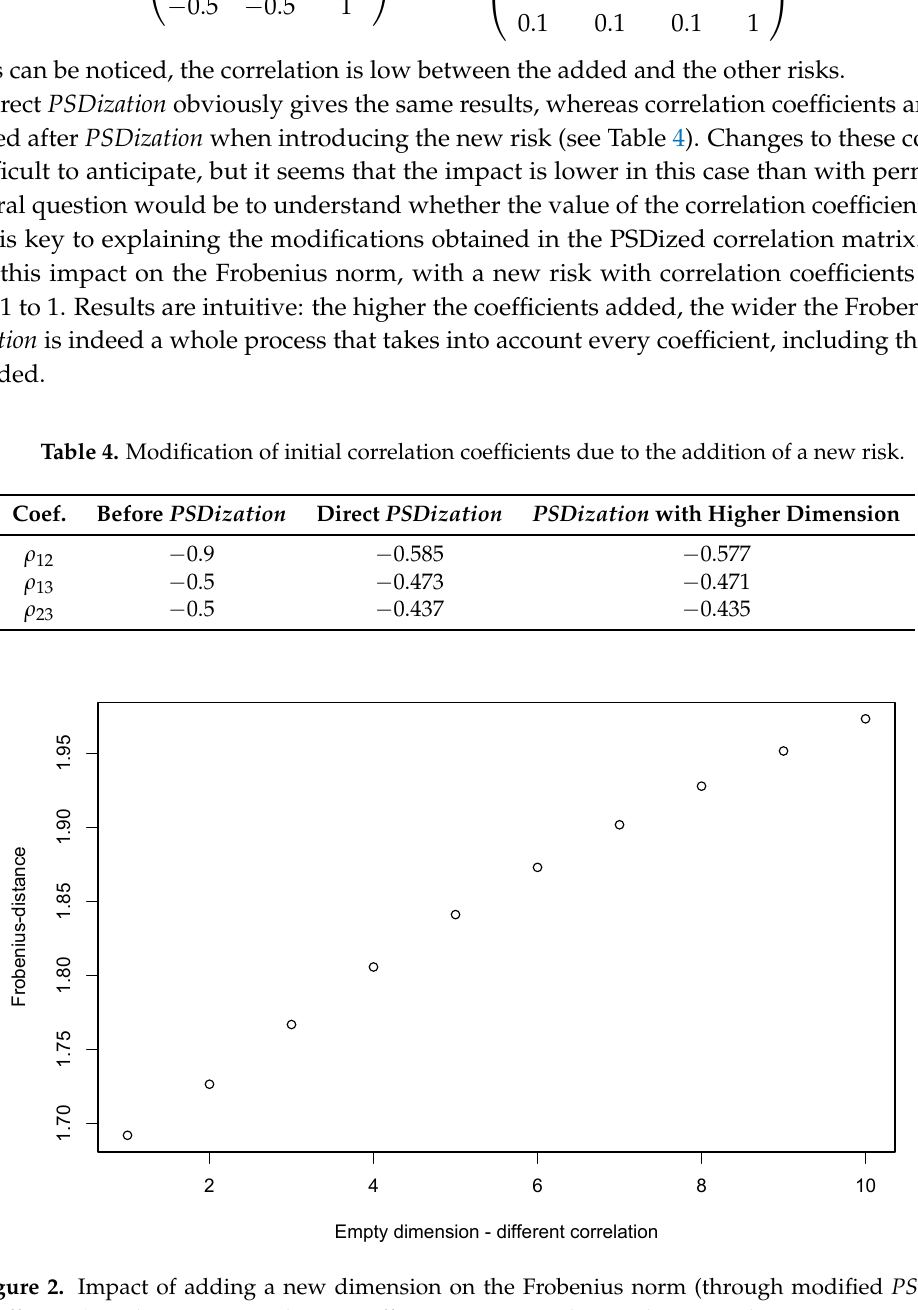
Figure 2. Impact of adding a new dimension on the Frobenius norm (through modified PSDized coefficients), with various correlation coefficients corresponding to the new